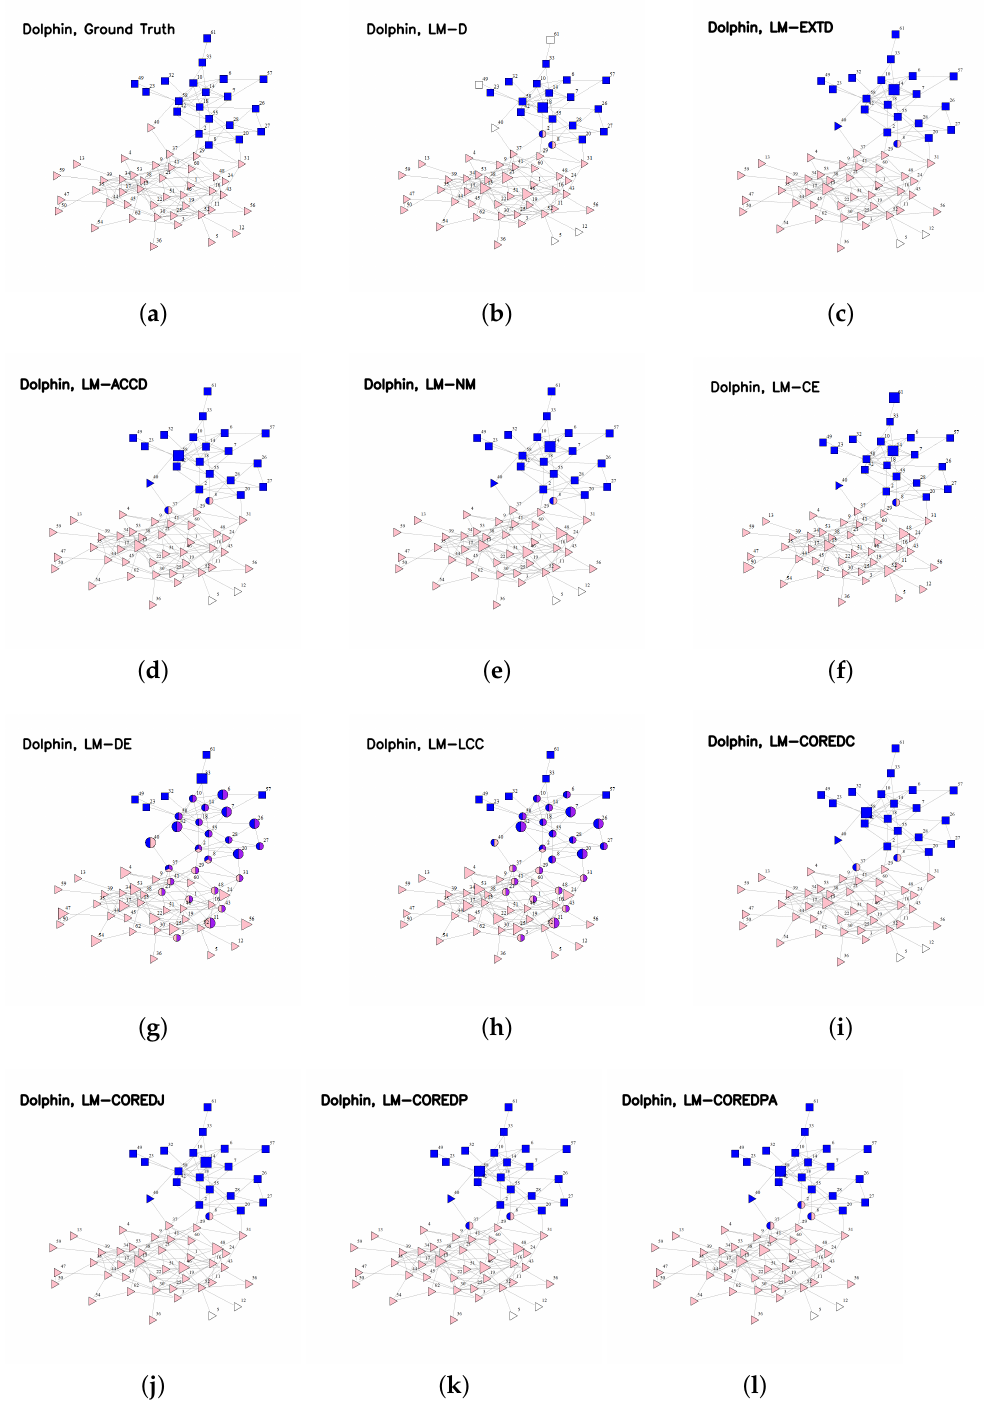
Figure 3. Visualization of the communities resulting from different local seeding algorithms for the Dolphin network. The two ground-truth communities are distinguished by squares and triangles. Members of the same detected community are marked with one color, and the overlapping members are indicated by circles with several colors corresponding to the communities to which they belong. White nodes do not belong to any